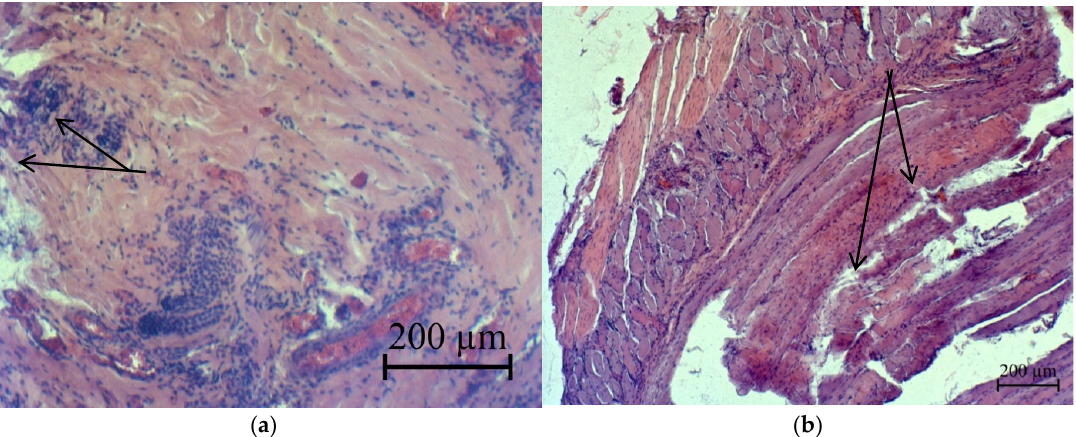
Figure 23. Accumulation of cellular infiltrate between muscle fibers: focal necrosis of muscle fibers (indicated by the arrow): ( a )—the second group and ( b )—the third group.